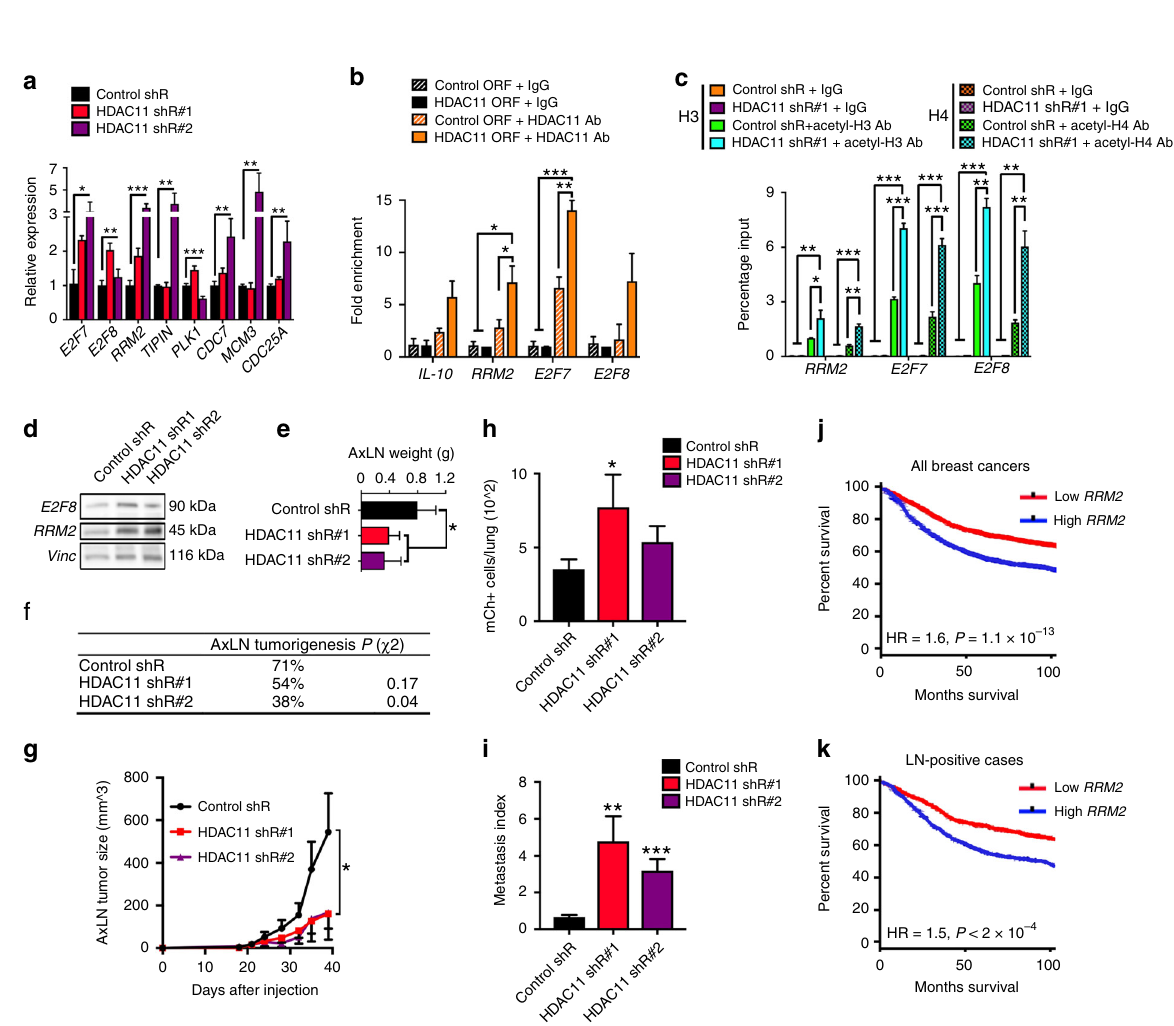
Fig. 4 HDAC11 suppression results in reduced lymph node growth but increased metastasis. a Relative expression of a set of down-regulated array genes after HDAC11 suppression by shRNA. Statistical signi fi cance was measured by ANOVA in comparison to the control shR samples. b Levels of immunoprecipitated promoter regions for IL-10 , RRM2 , E2F7 , and E2F8 in human MDA-MB-231 cell lines expressing either control or HDAC11 ORFs when pulling down with either IgG control or HDAC11 antibodies. Statistical signi fi cance was measured by ANOVA. c Levels of immunoprecipitated promoter regions for RRM2 , E2F7 , and E2F8 in 4T1 cell lines stably expressing either control or HDAC11 shR when pulling down with either IgG control, acetyl-H3, or acetyl-H4 antibodies. Statistical signi fi cance was measured by ANOVA. d Western blots for E2F8 and RRM2 in 4T1 lines expressing control or HDAC11 shRs. e LN tumor weights at day 35 following axillary LN micro-injection. f Take rates of LN-micro-injected 4T1-shHDAC11 cell lines compared to 4T1-shCtrl cells. P value obtained using a χ 2 contingency test. g LN tumor volumes throughout the duration of the experiment ( n = 13 – 14 mice/group). Statistical signi fi cance was measured by unpaired one-sided Student ’ s t tests. h Lung micro-metastasis enumeration for LN-micro-injected mice by mCh + fl ow cytometry. i Lung metastasis index after normalization to LN tumor size ( n = 13 – 14 mice/group). Statistical signi fi cance was measured by unpaired one-sided Student ’ s t tests ( h + i ). j , k Disease-free survival curves from the BreastMark collection comparing patients with high and low levels of RRM2 in all available breast cancer samples ( n = 2652 patients), as well as in LN + cases ( n = 744 patients). Statistical signi fi cance was measured by log-rank test. P values are indicated as * p < 0.05, ** p < 0.01, and *** p <